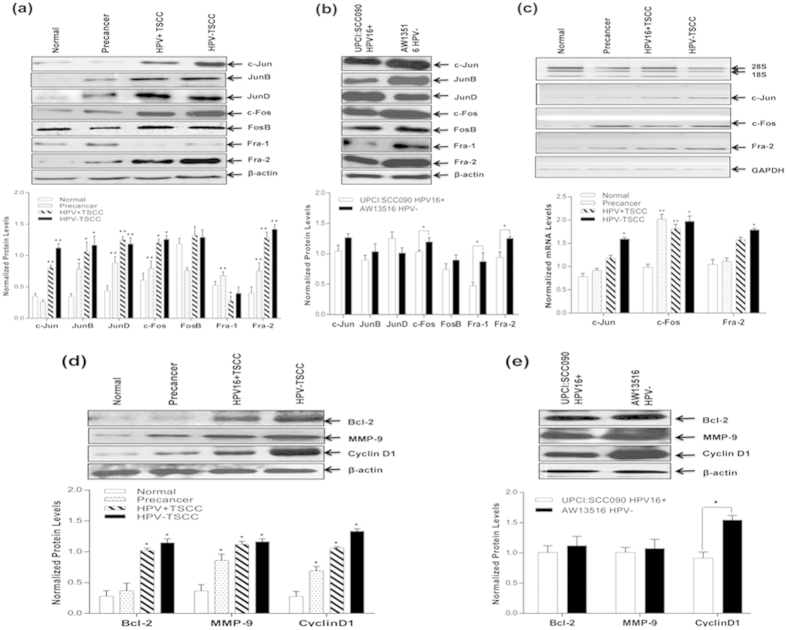
(a–e): Differential expression pattern of AP-1 family proteins and their target genes in different grades of tongue tissues and cell lines. Representative immunoblots showing overexpression of AP-1 family proteins (c-Jun, JunB, JunD, c-Fos & Fra-2) and their target genes (Bcl-2, MMP-9 and Cyclin D1) in tongue tumor biopsies (a) and cell lines (b). 40 μg cellular protein from tongue tissues and cell lines were resolved on 10% SDS-PAGE, electrotransferred and probed with specific antibodies against all AP-1 family proteins and their target genes (Bcl-2, MMP-9 and Cyclin D1). To confirm equal loading of protein, the membranes were stripped and re-probed for β-actin expression and quantitation of bands was performed by densitometric analysis (lower panel of a & b). Note that there is significantly a higher expression of c-Fos & Fra-2 in tumor tissues, while Fra-1 is completely absent. Panel c; RT-PCR showing elevated mRNA expression profile of c-Jun, c-Fos & Fra-2 transcripts in tongue tumor tissues (c). GAPDH gene was used as internal loading control (lower panel of c). (Panel d,e); showing overexpression of Bcl-2, MMP-9 and Cyclin D1 genes in HPV+ve and HPV−ve tongue tumor tissues (d) and cell lines (e). β-actin gene was used as an internal control (lower panels of d,e). Significant (p < 0.05) when compared with control vs. cases and HPV+ve vs. HPV−ve cell lines. The data in bar diagram are expressed as the mean (±SEM or ±SD) of three independent experiments. *p < 0.05 & **p < 0.01, ***p < 0.001.